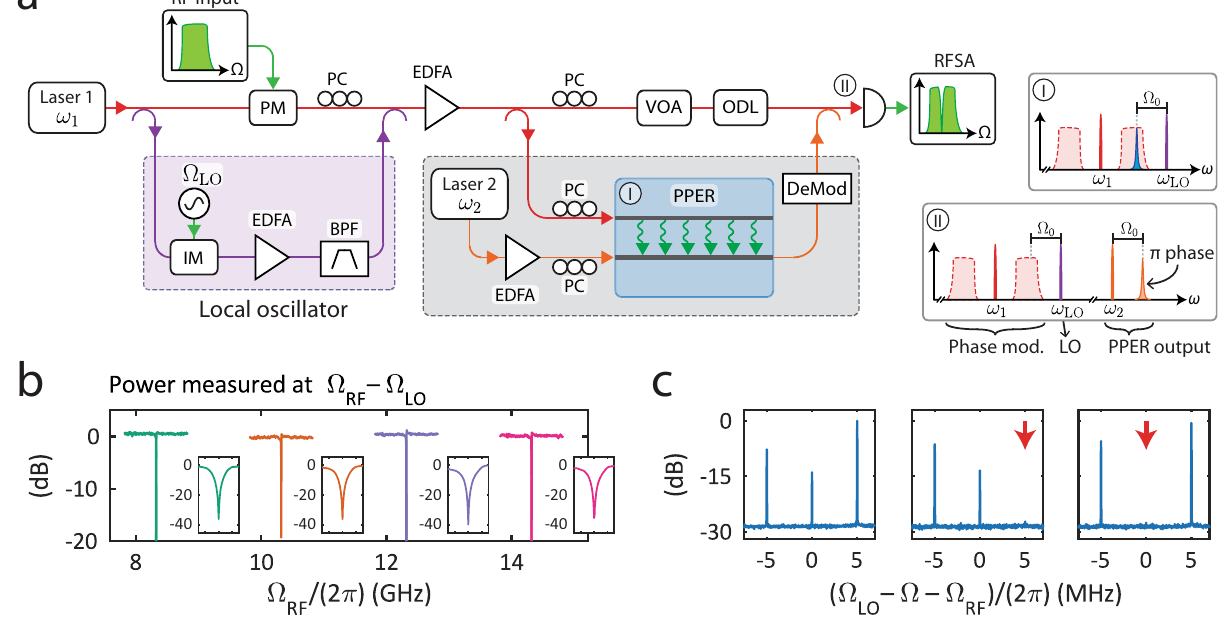
Fig. 3 Microwave-photonic notch fi lter frequency tunability. a Schematic illustration of the experimental setup used to tune the notch frequency. The input RF signal is modulated using a phase modulator (PM). An optical local oscillator (LO) tone is synthesized using an intensity modulator (IM) and an optical bandpass fi lter (BPF). VOA variable optical attenuator, ODL optical delay line, EDFA erbium-doped fi ber ampli fi er, PC polarization controller, DeMod phase demodulation (bandpass fi ltering), RFSA RF spectrum analyzer. b Aggregated data from four measurements demonstrating the tunability